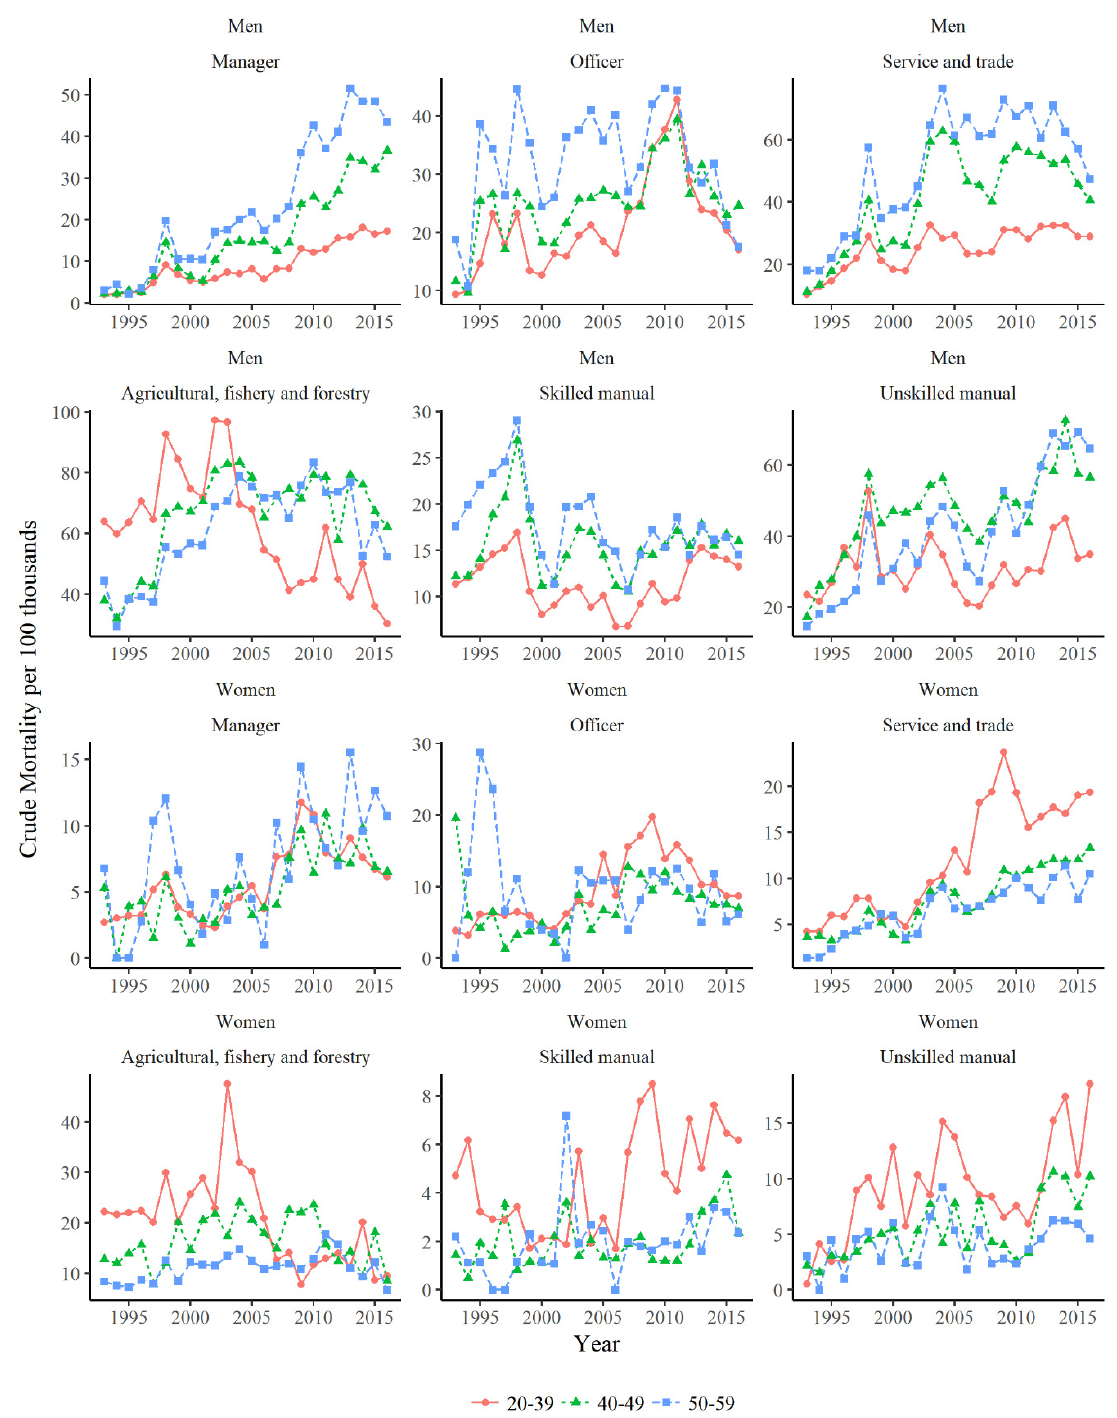
Figure 2. Crude mortality per 100,000 according to age groups 20–39, 40–49, and 50–59. Note: In each graph, different scales were used to highlight the comparison between age groups.